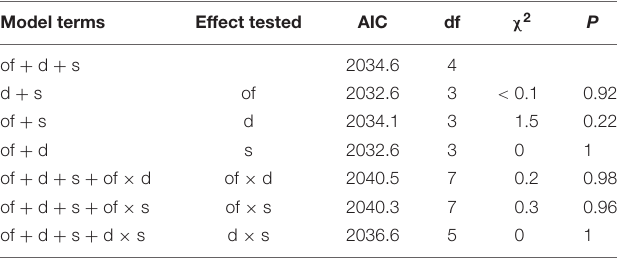
TABLE 1 | Likelihood ratio tests on generalized mixed-effects models testing for parental and treatment effects (fertilization based on sperm competition with or without ovarian fluids) on primary sex ratios.